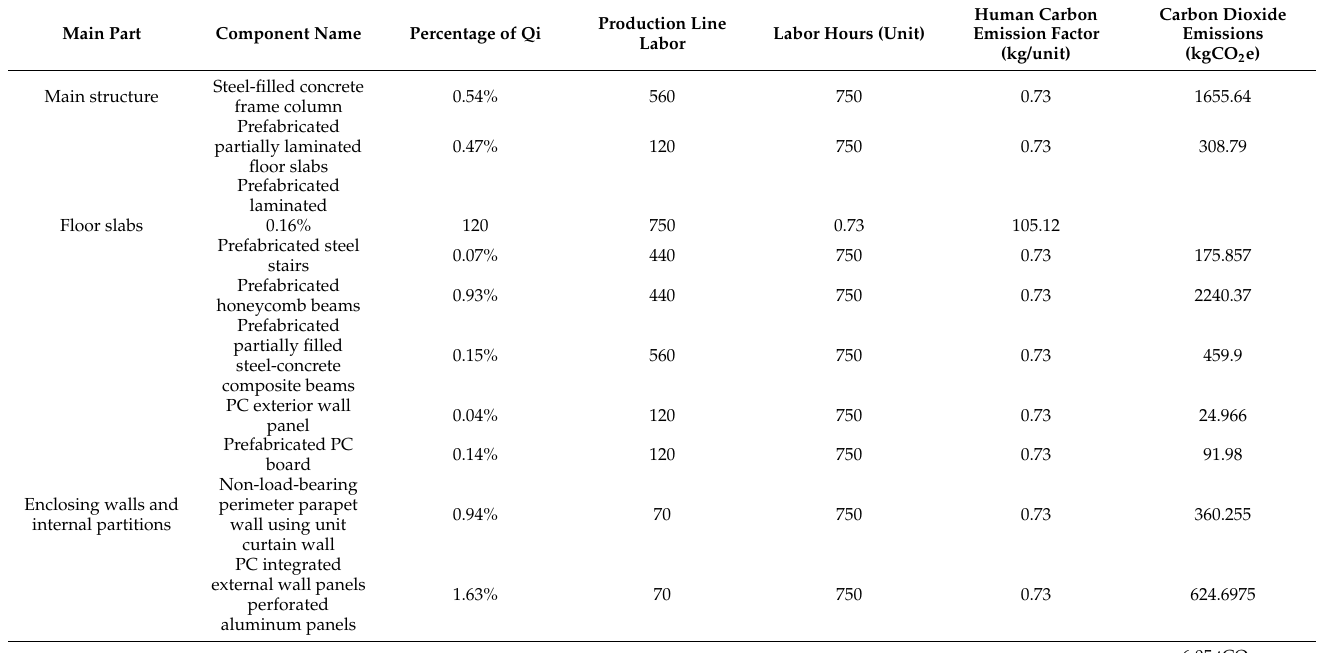
Table 11. Carbon emissions of T p i .